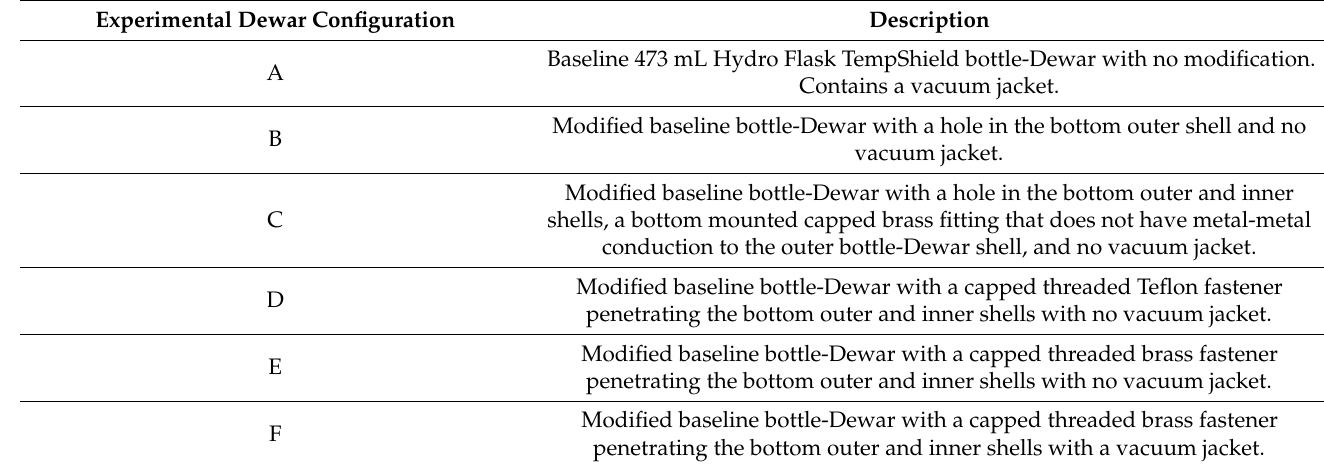
Table 1. Experimental Dewar configuration designations for the baseline Hydro Flask and five modified configurations of the